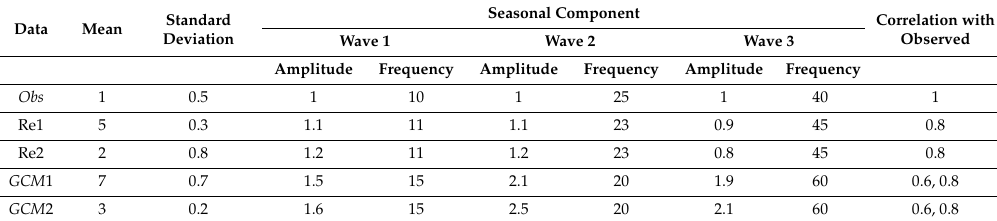
Figure 1. Typical patterns of Synthetic series for ( a ) Set1 and ( b ) Set2. Re2 and GCM2 are not shown for better clarity. Table 4. Parameters of series for